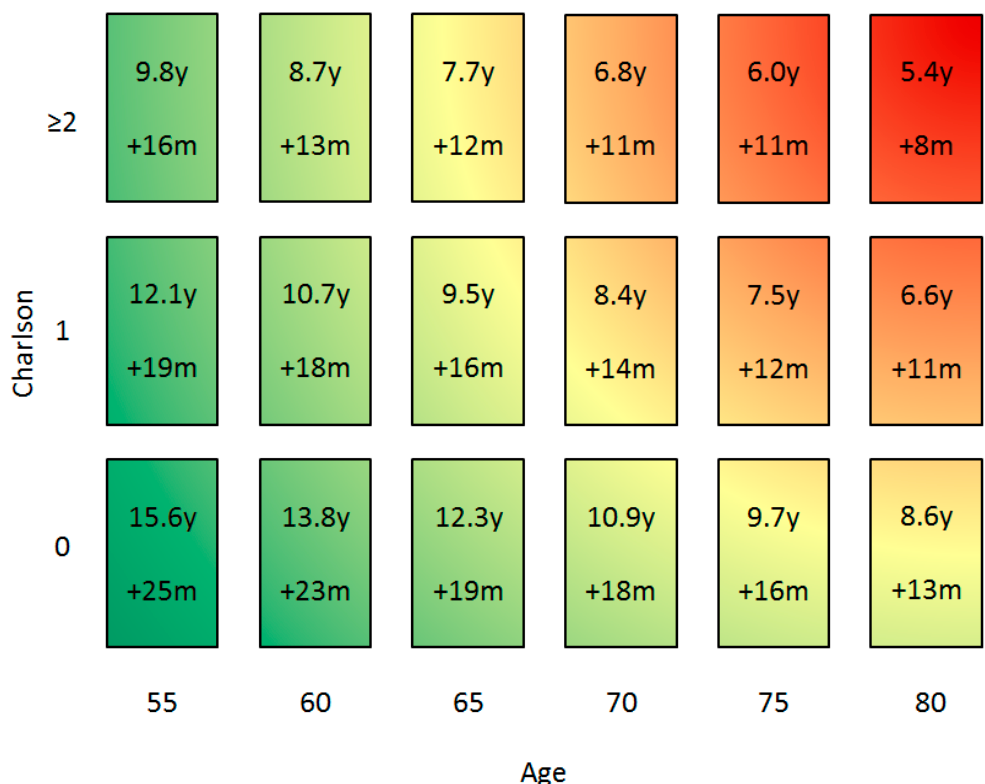
Figure 2. Life expectancy in years (y) for patients with clinically significant prostate cancer receiving no treatment based on Weibull distribution from the SEER. Secondly, gain in life expectancy (LE) in months (m) by csPCa treatment based on the relative risk reduction for all-cause mortality from the Prostate Cancer Intervention versus Observation Trial (PIVOT). The green color indicates a patient should be referred to a urologist, red indicates the patient should not be referred. Colors overlap because risk of csPCa on a current biopsy should also be weighted.